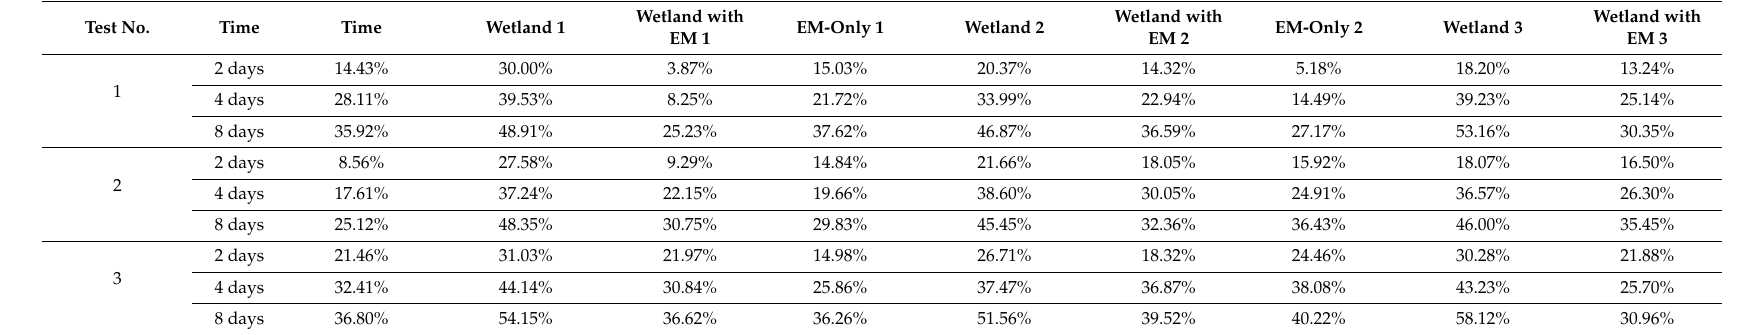
Table 5. TP concentration reduction rates in wetlands over 8